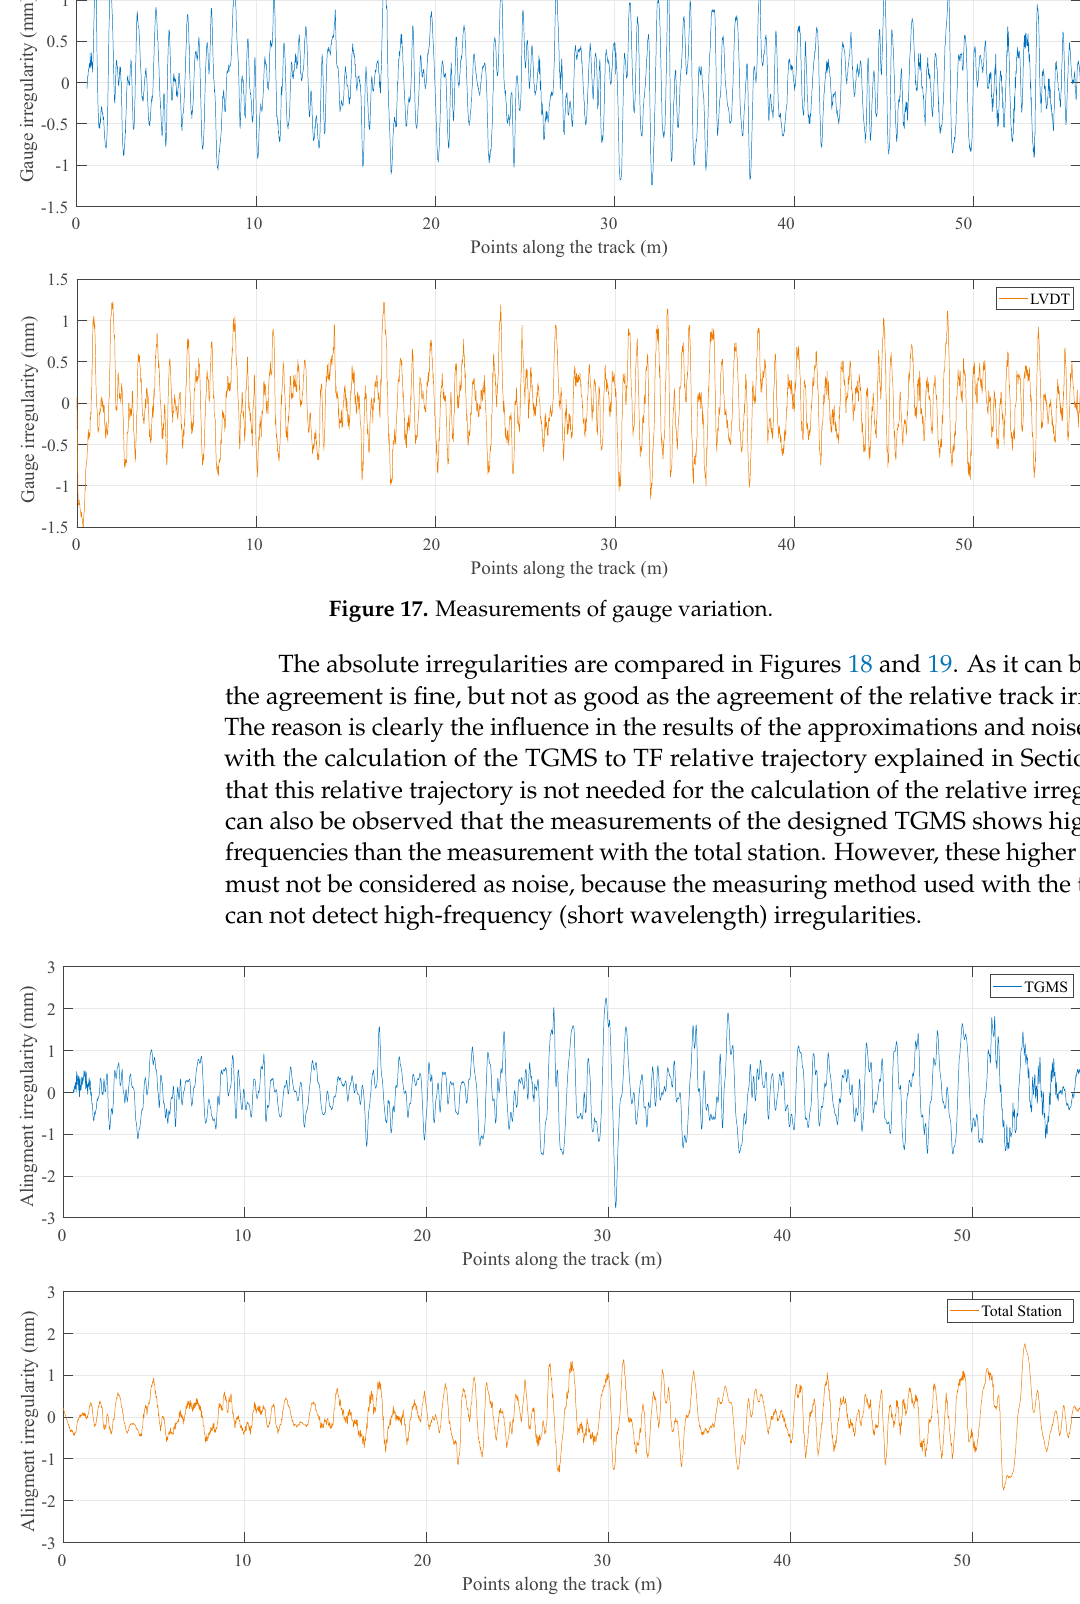
Figure 18. Measurements of